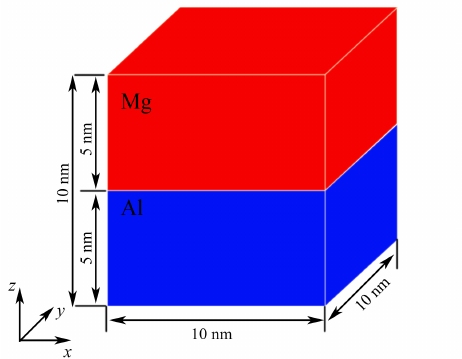
Figure 1. Schematic of the initial